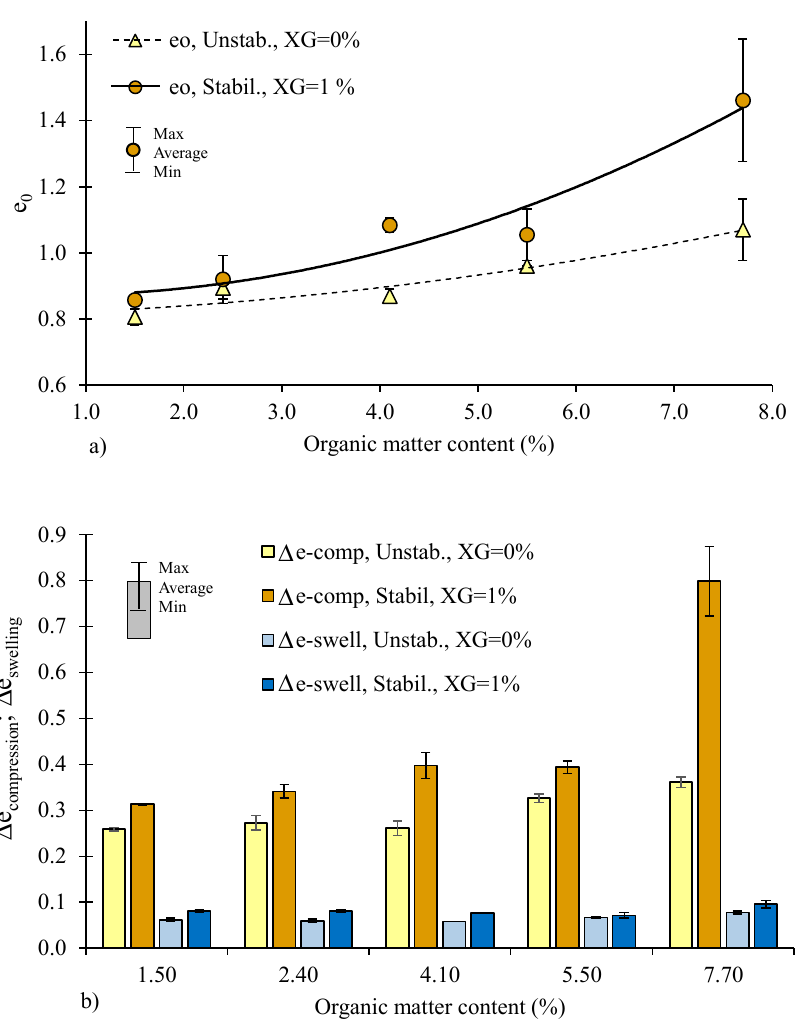
Figure 7. Oedometer tests. Effect of organic matter content on the: ( a ) initial void ratio, ( b ) variation of void ratio during compression (9.0 to 902 kPa) and swelling (902 to 1.5 kPa).